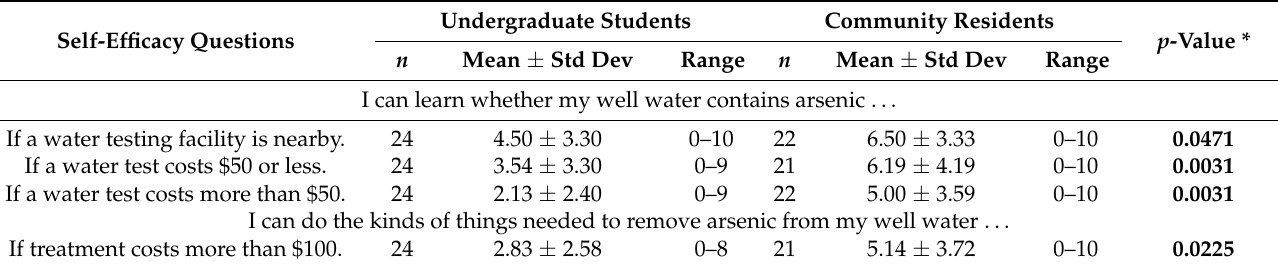
Table 6. Self-Efficacy items with statistically significant differences between